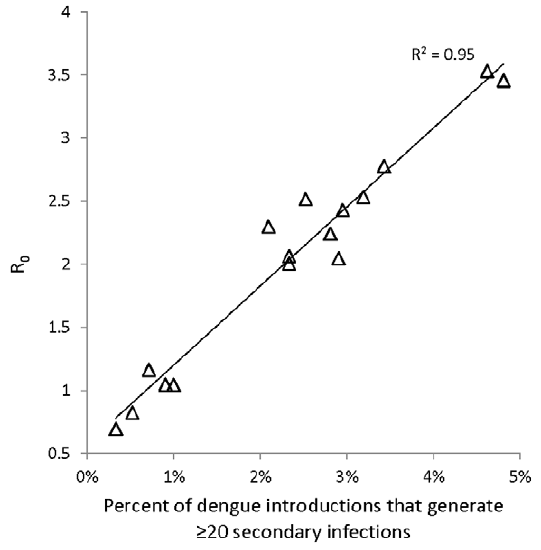
Figure 3. Correlation between percent of dengue introduction iterations that generate $ 20 secondary infections and R 0 (secondary infections averaged over 300 introduction trials for each of 7 pupal surveys) across 16 study patches in Armenia, Colombia.